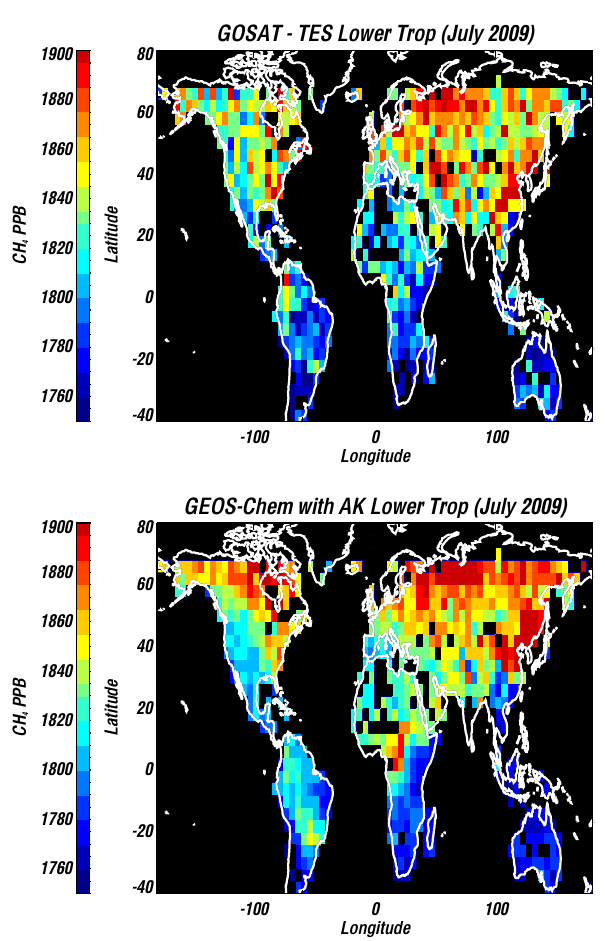
Figure 6. Top: CH 4 lower-tropospheric estimate using GOSAT and TES data. Black indicates no data. Bottom: lower-tropospheric es- timate from GEOS-Chem model for the same latitudes and longi- tudes shown in top panel of Fig.